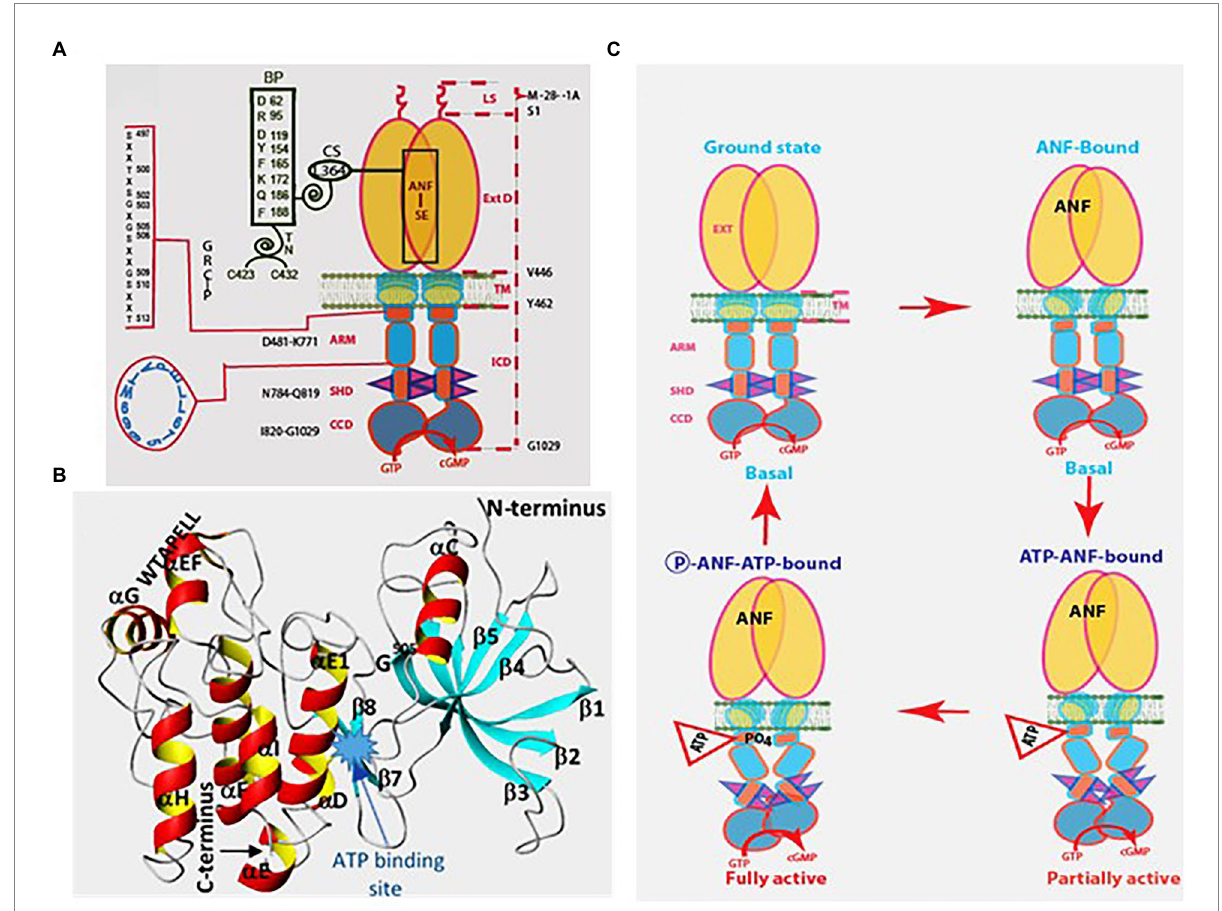
FIGURE 5 Model for signal transduction by atrial natriuretic factor-receptor guanylate cyclase (ANF-RGC). (A) Module segments involved in activation. An ANF-signaling element (ANF-SE) resides in the ExtD. A Central Switch (CS), L 364 , controls the ANF binding site. A binding pocket (BP) is hinged with the CS (van den Akker et al., 2000; Ogawa et al., 2004, 2009). Two disulfide bridged cysteine residues act as a transduction node (TN) to guide the transmembrane migration of the ANF signal to an intracellular, ATP-Regulated Module (ARM; Duda et al., 2005b). Significantly, the TN is active only in the hormone receptor guanylate cyclases but not in the photoreceptor guanylate cyclases (Shahu et al., 2022). ATP amplifies the ANF signal by bringing two critical domains to the surface: a glycine rich cluster G-X-G 505 -X-X-X-G, making surrounding serine and threonine available for phosphorylation (GRC-P) and a 7-aa residue W 669 -TAPELL 675 motif to activate the core catalytic domain (CCD). (B) Structure of the ARM in its apoform. Four antiparallel β strands and one helix constitute the small lobe. The large lobe is made up of eight α helices and two β strands. The positions of the key G 505 residue of the GRC motif within the small lobe and of the W 669 -TAPELL 675 motif within the large lobe are indicated. ATP binding is sandwiched between the two lobes indicated by a star. (C) Activation model for ANF-RGC. Binding of an ANF molecule to the ExtDs of the dimer primes the ANF-SE, by rotating TN. The twisting motion propagates through TM to prepare ARM for ATP binding (Ogawa et al., 2004; Parat et al., 2010). ATP binding triggers a cascade of temporal and spatial changes (Duda et al., 2001c). With G 505 in GRC-P acting as a pivot, the ATP binding site shifts its position and its floor rotates. There is movement of ARM’s β 4 and β 5 strands and the loop between them and movement of the α E and F helices that exposes the hydrophobic WTAPELL motif for interaction with CCD (Duda et al., 2009). These structural rearrangements initiate 50% maximal catalytic activity. Full activation is attained after multiple serines and threonines in GRC-P become phosphorylated (Duda et al., 2011b). The conformational changes wrought by ATP binding reduce the affinity of ANF-RGC for ANF and phosphorylation lowers the affinity for ATP binding. Dissociation of ANF and ATP return ANF-RGC to its ground state. (Modified from Duda et al., 2011b; Sharma et al.,